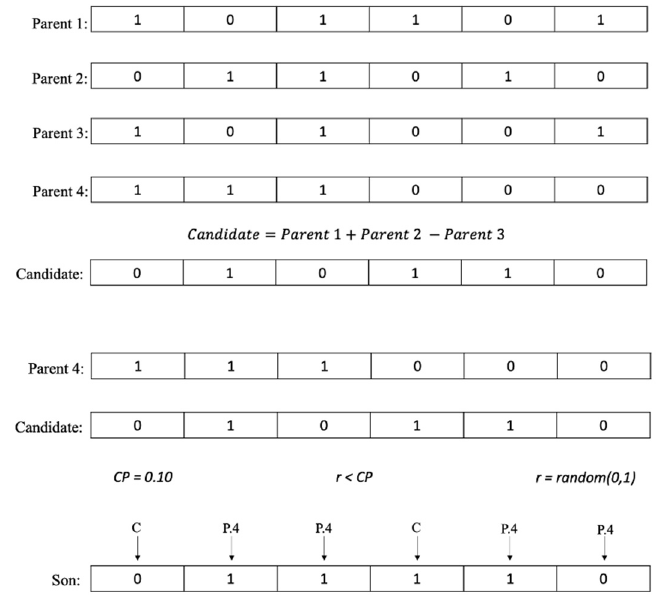
Figure 6. Differential evolution operator example.